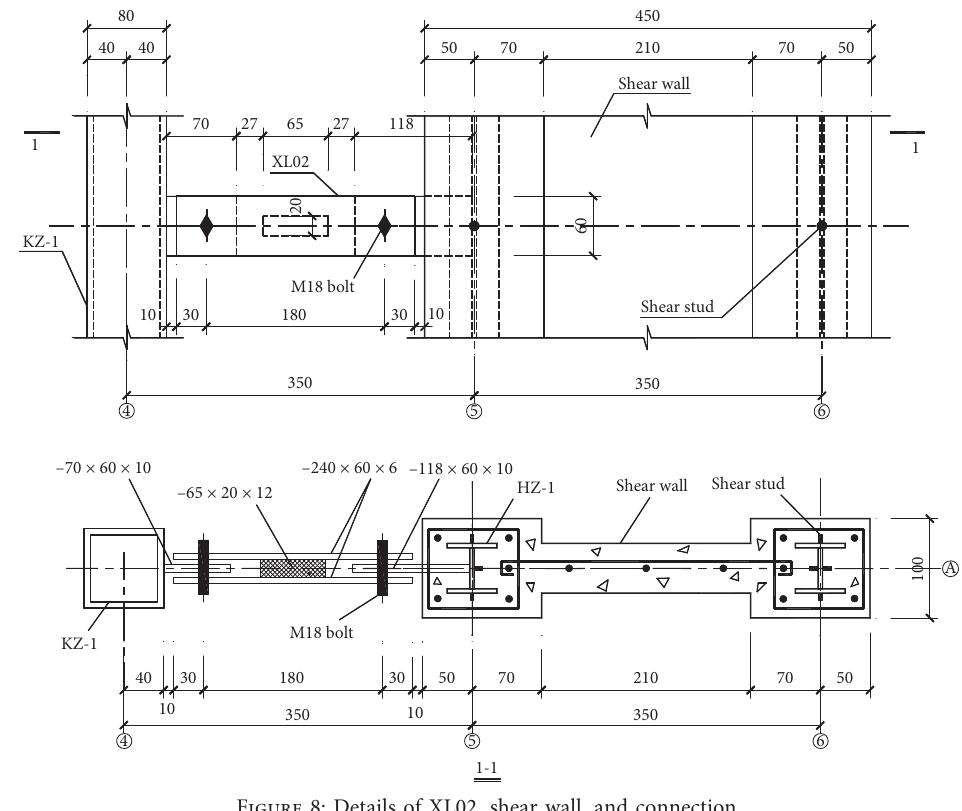
Figure 8: Details of XL02, shear wall, and connection.